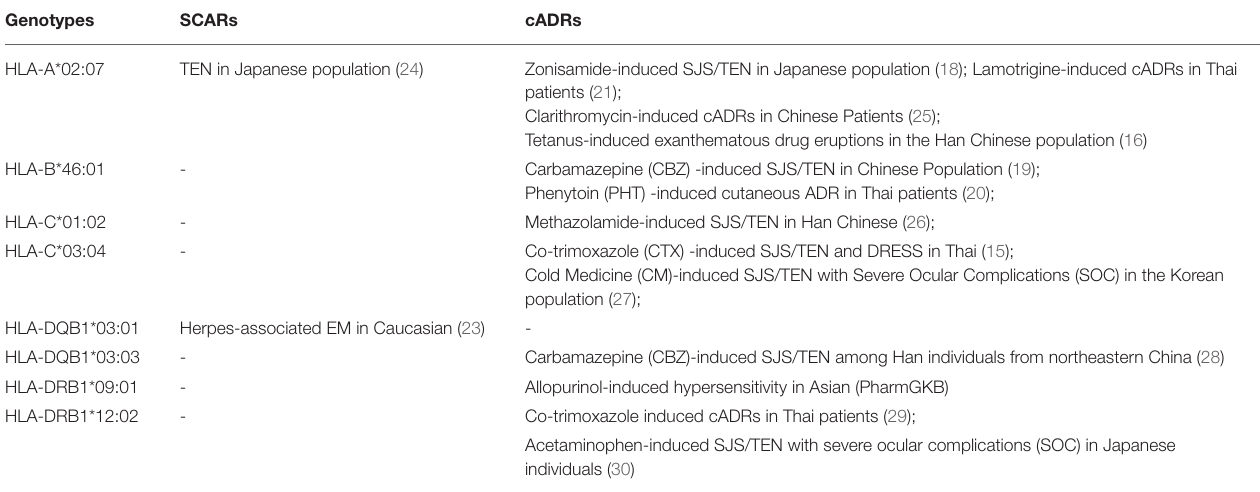
TABLE 2 | Relevant genotypes-based pharmacogenomics relationships between HLA alleles and cutaneous adverse reactions. Genotypes